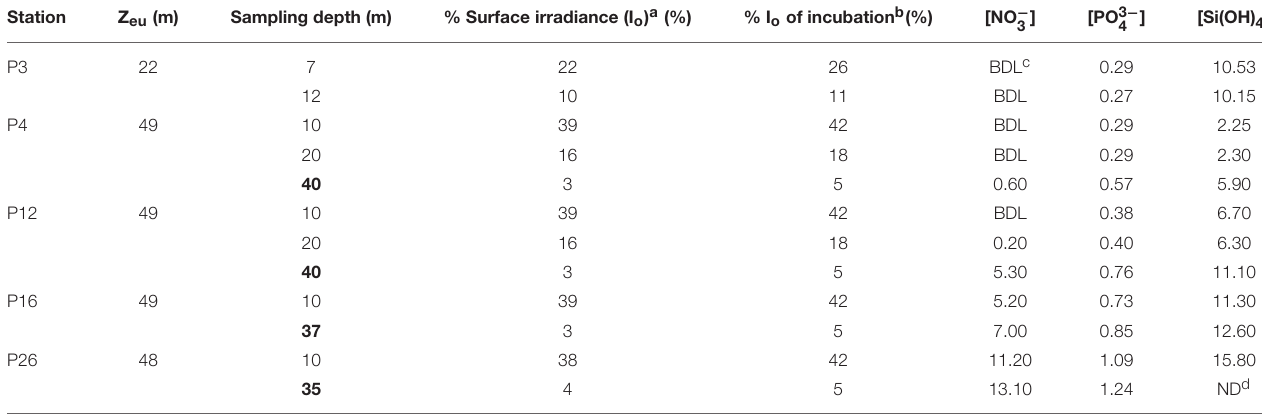
TABLE 2 | Light intensities, euphotic zone depth (Z eu ), and macronutrient concentrations ( μ M) at each sampling depth along Line P. Station